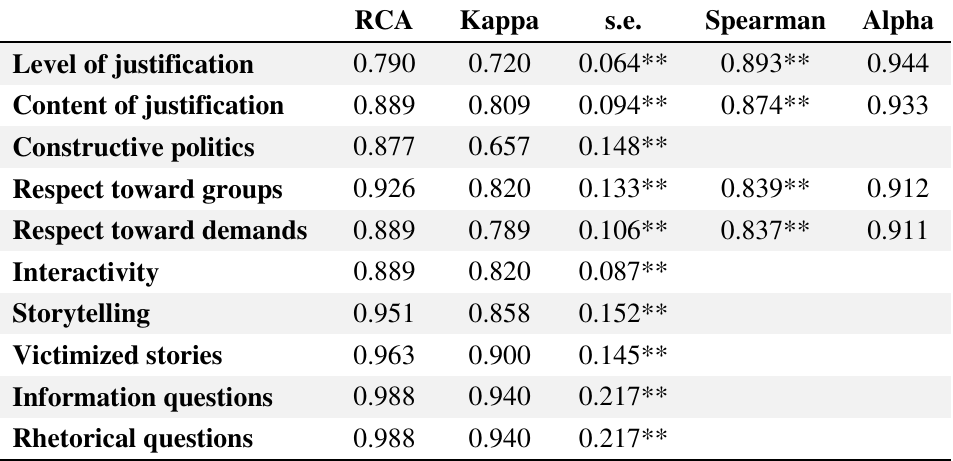
Table 6: Inter-coder Agreement per Category